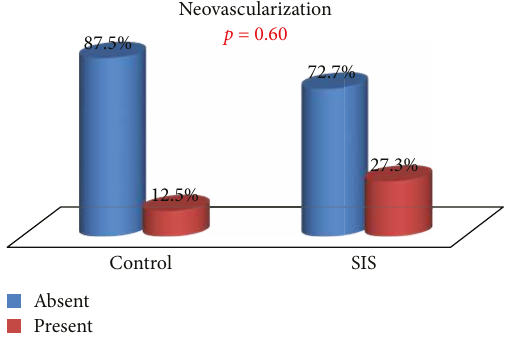
Figure 11: Neovascularization: group comparison.